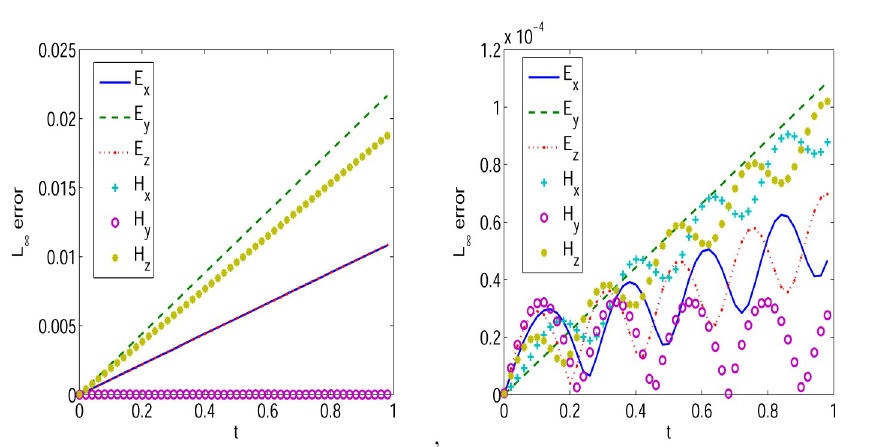
Fig 10. L 1 errors of numerical solutions to LOD central box scheme (left) and LODEFMS scheme (right) in second testing case.